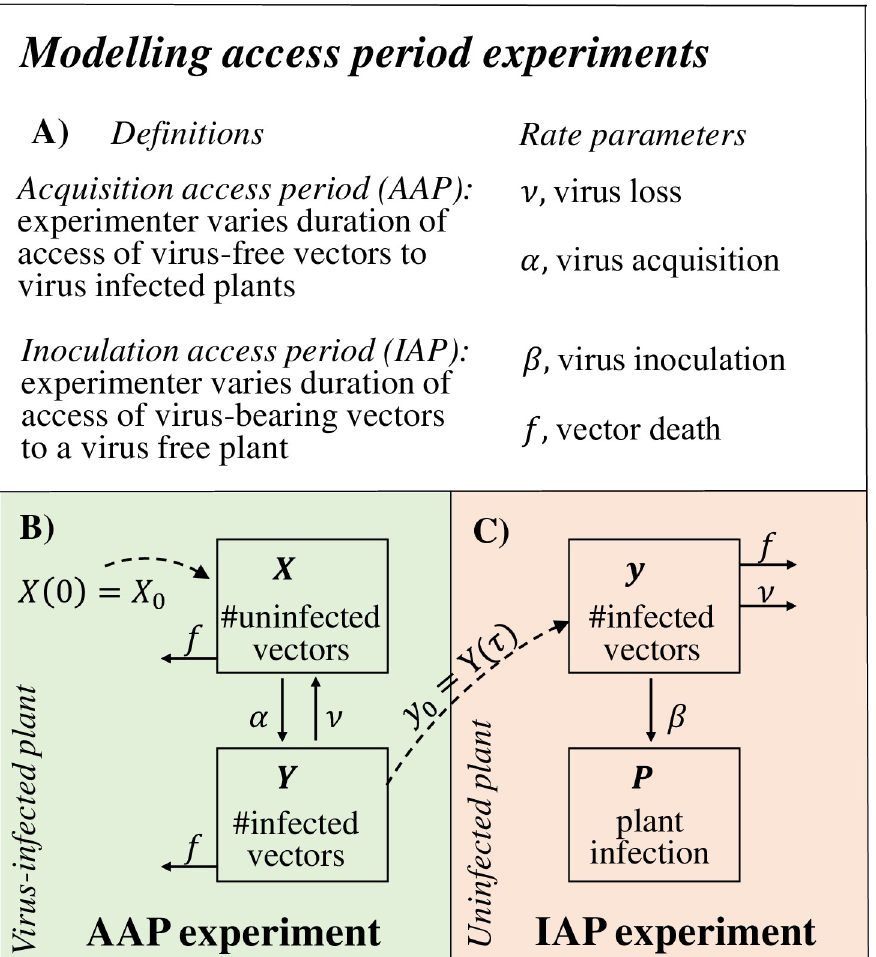
Fig 1. Key definitions (A) and a biological description of access period experiments (B-C). Flow charts of B: the acquisition access component, and, of C: the inoculation access component, of access period